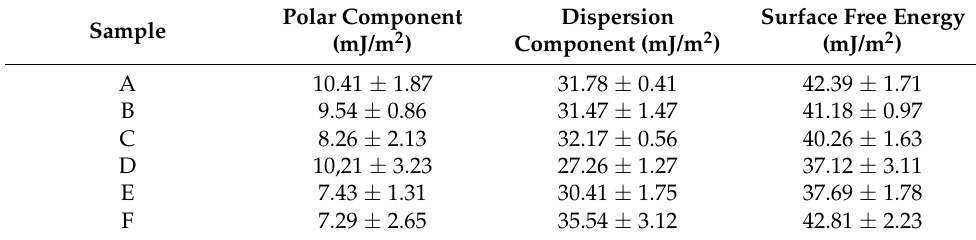
Table 4. Values of free energy of